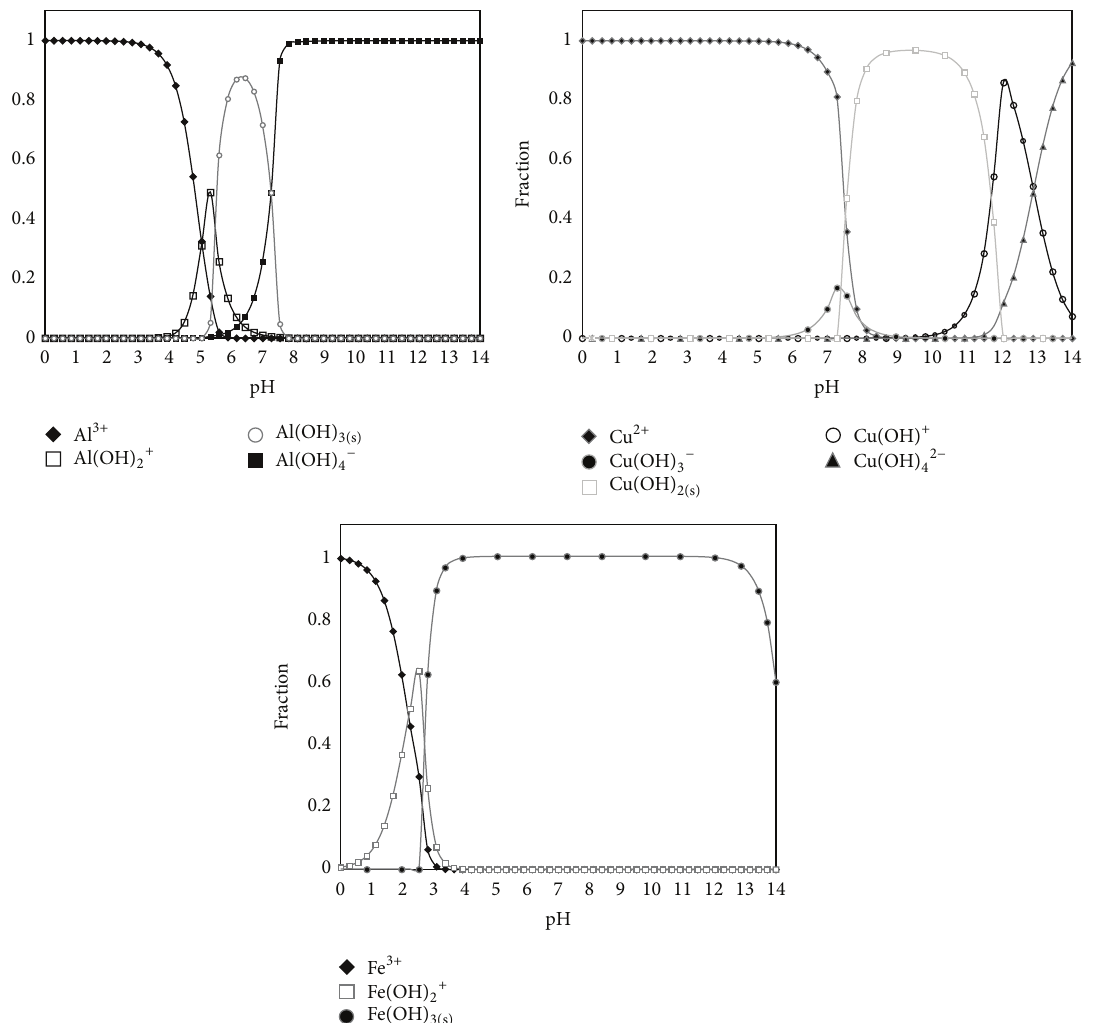
Figure 2: Chemical species diagram for Al, Cu, and Fe in aqueous solution as a function of pH. These diagrams were obtained using the MEDUSA